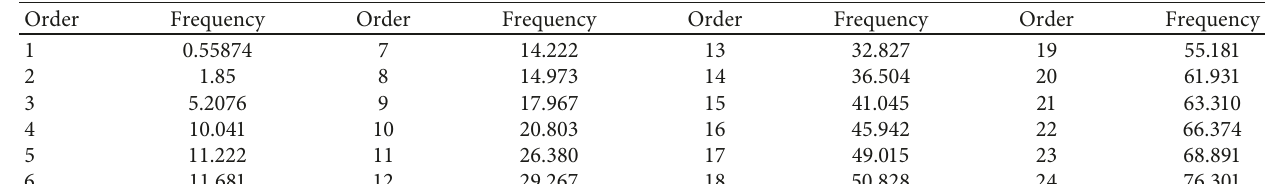
Figure 4: Deformation of coke pusher. Table 3: The first 24 natural frequencies of structure of coke pusher.